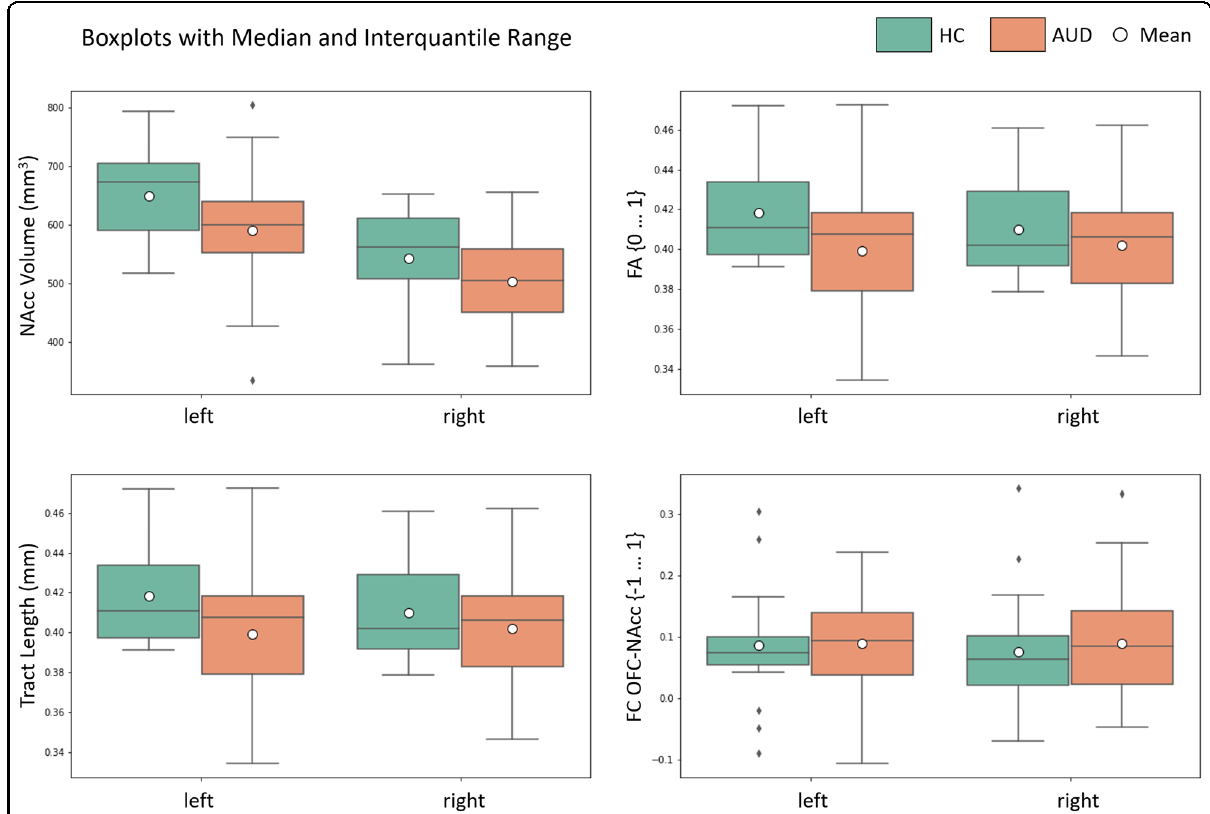
Fig. 2 Boxplots for AUD and HC are displayed for the respective imaging modalities. There was a signi fi cant group main effect for NAcc volume (bilateral), for FA of the left OFC-NAcc segment and for tract length (bilateral). OFC-NAcc FC did not differ between